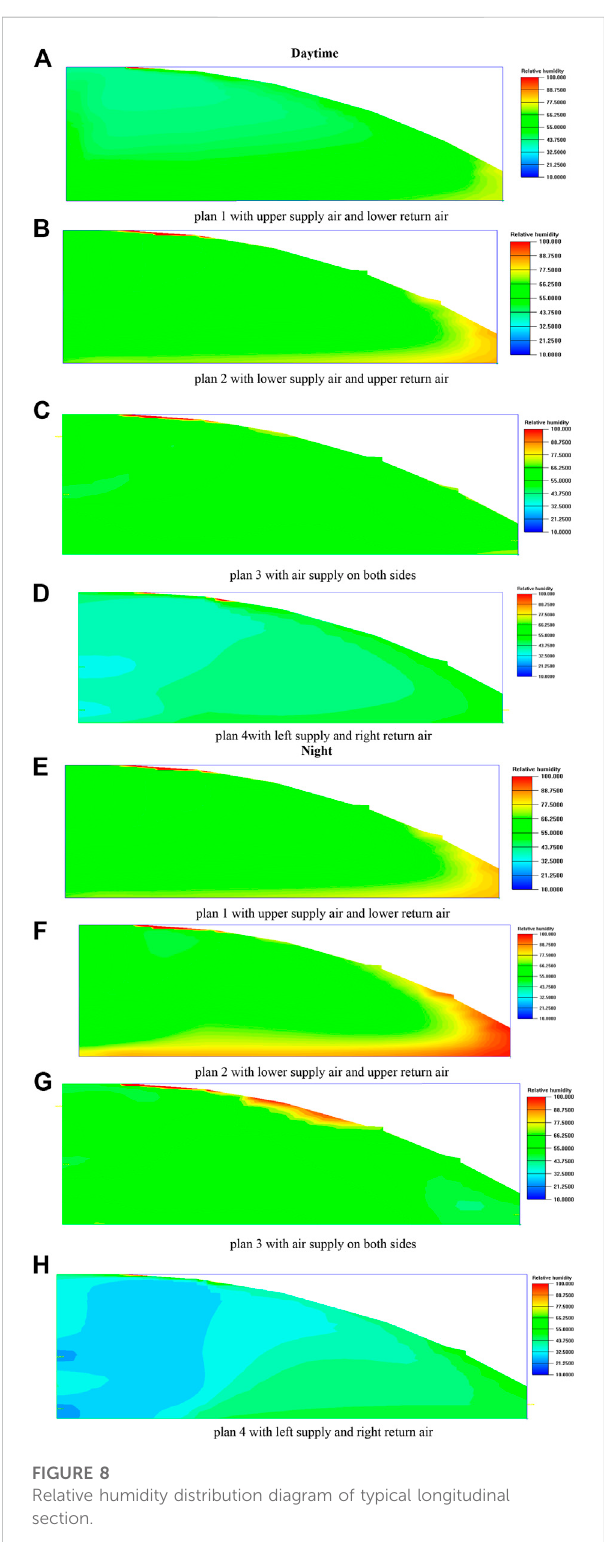
FIGURE 8 Relative humidity distribution diagram of typical longitudinal